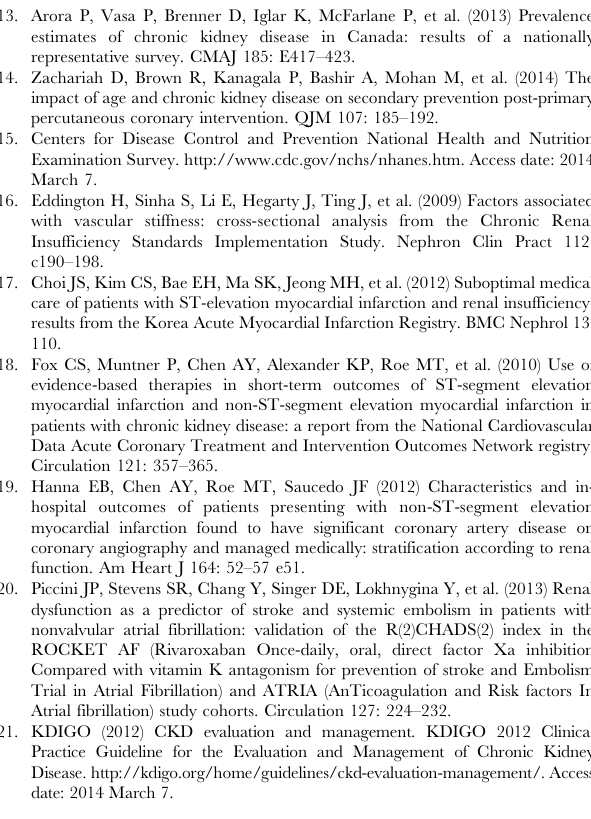
Table S2 Chronic Kidney Disease–Epidemiology Collaboration